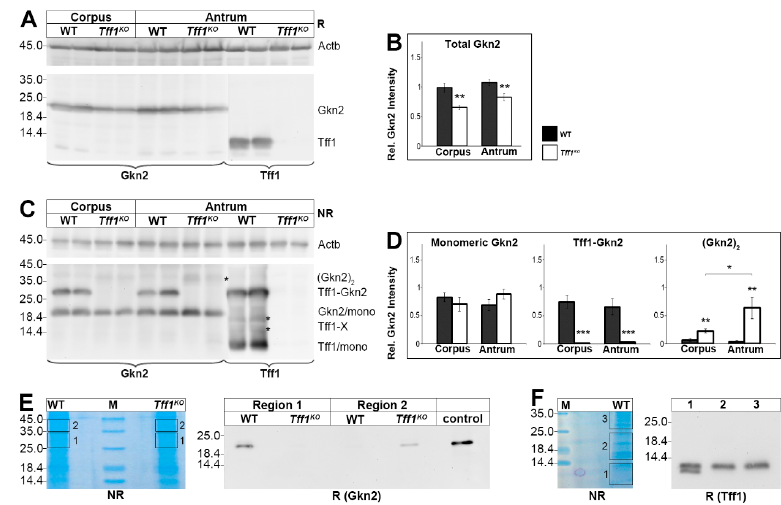
Figure 2. Western blot analyses of gastric corpus and antrum extracts of wild-type (WT) and Tff1 KO animals. ( A ) Extracts of two male animals of each group were separated on a 15% SDS-PAGE under reducing conditions, and analyzed for Gkn2 and Tff1, respectively. Left: molecular mass standard. Loading control: reactivity for ß-actin (Actb). ( B ) Semi-quantitative analysis of the relative Gkn2 content (10 male animals per group). ( C ) Analysis of the same samples as in (A), but under non- reducing conditions. Marked are the positions of the Gkn2 homodimer ((Gkn2) 2 ; indicated by an asterisk), the Tff1-Gkn2 heterodimer, the Gkn2 monomer, possible Tff1-X homo/heterodimers (indicated by asterisks), and the Tff1 monomer. ( D ) Semi-quantitative analysis of relative monomeric Gkn2, heterodimeric Tff1-Gkn2, and homodimeric (Gkn2) 2 contents, respectively (10 male animals per group). ( E ) Left: Non-reducing SDS-PAGE (Coomassie-stained) of antral extracts pooled from three female WT and three female Tff1 KO animals (55 µg protein per lane) and elution of the regions 1 and 2; M, molecular mass standard. Right: Reducing Western blot analysis of the eluates concerning Gkn2. ( F ) Left: Non-reducing SDS-PAGE (Coomassie-stained) of a corpus extract of a single male WT mouse and elution of the regions 1–3. Right: Reducing Western blot analysis of the eluates concerning Tff1. Significances are indicated by asterisks (*, p ≤ 0.05; **, p ≤ 0.01; ***, p ≤ 0.001). WT animals: black bars; Tff1 KO animals: white bars.